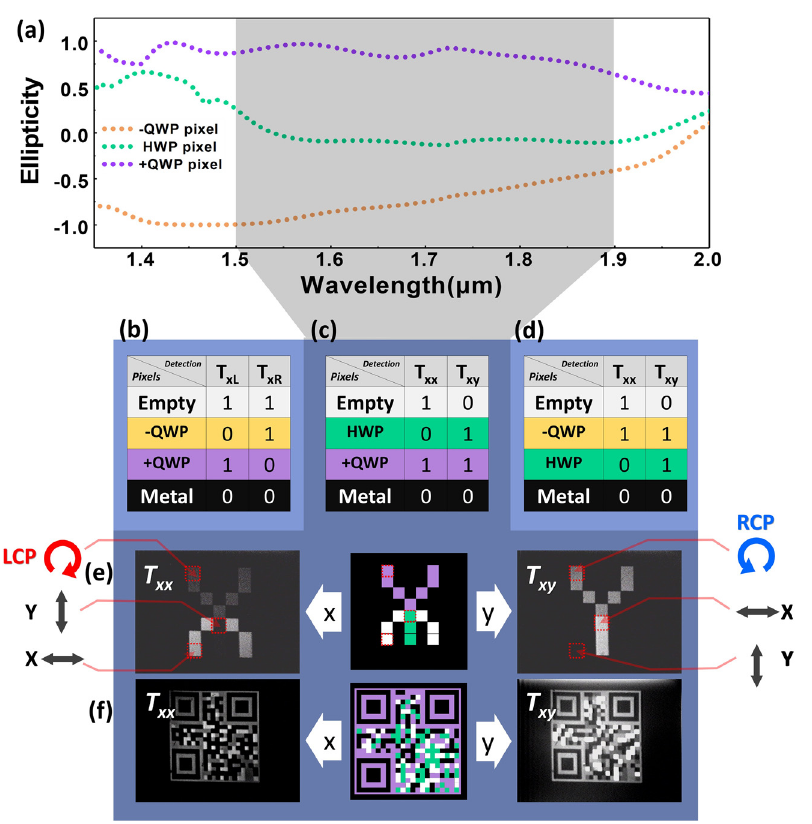
Different color areas in the schematic represent different kinds of pixels in the code table of Figure 5(c). The left and right images of Figure 5(e) are the stored images read out by copolarization ( x -LP input) and cross-polarization ( y -LP input) transmitted setup in a broadband from 1.2 to 1.9 µm, respectively. The hybrid output polarizations are marked on these two intensity images. It can be found that the states of polarization on two output channels are orthogonal, which can largely avoid the cross-talk between channels. As well as the grayscale image encryption, the stored images here also have high resolution. Their ppi reaches 35,219, which is far more than that of typical printer (300 – 1440 ppi). Figure 5(f) is another example showing that two distinct high-resolution (1000 × 1000) QR codes can be simultaneously stored in an area less than 0.5 square millimeter. polarization type, and with the increasing of the channel